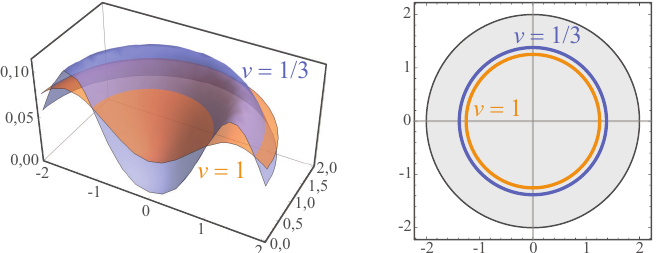
= 1 and B = 3 B = 1 , 0 (right) corresponding to ν 1/3 N 0 3